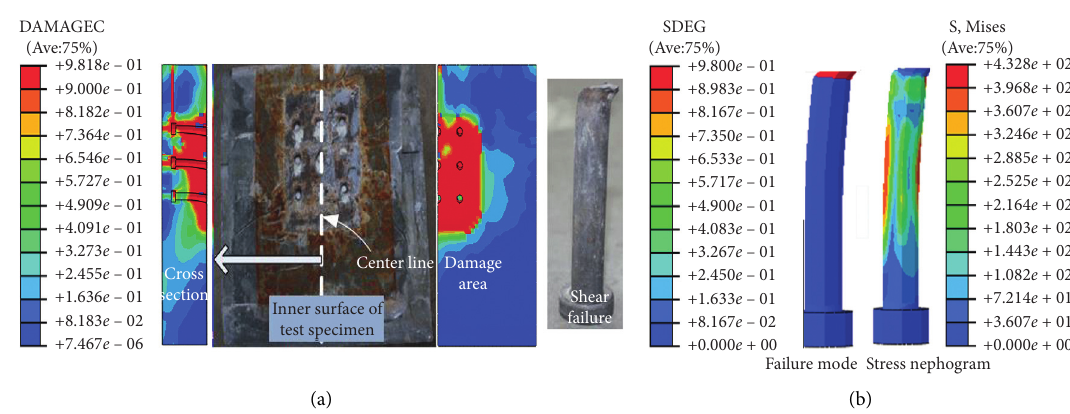
Figure 8: Analyzed failure of concrete and shear studs: (a) concrete damage; (b) stud damage and stress nephogram.